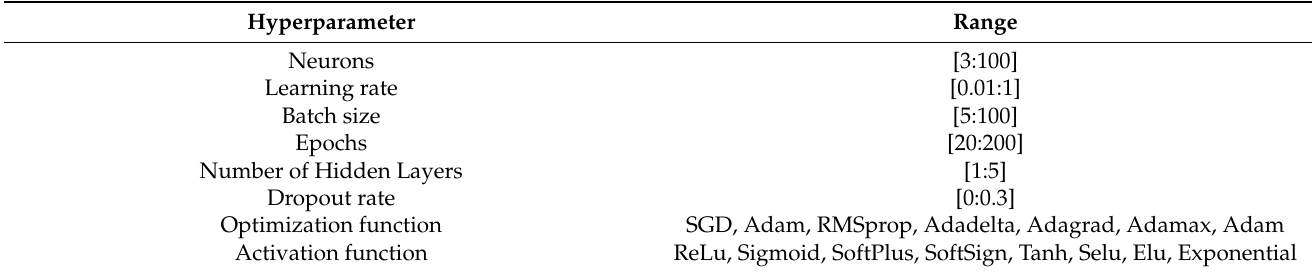
Table 4. Neural networks hyperparameter